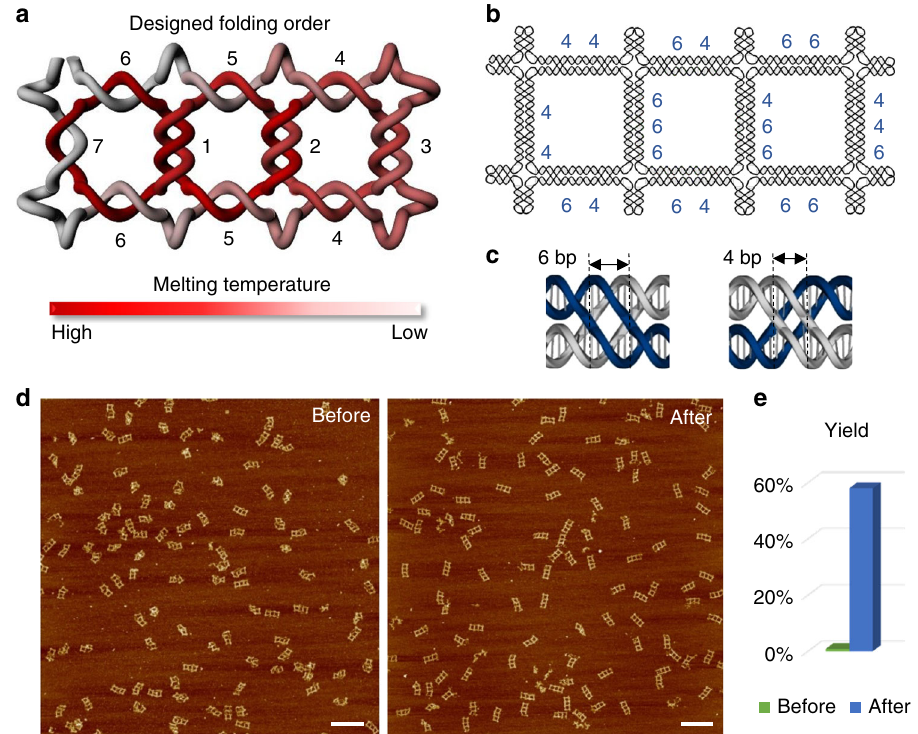
Fig. 3 Optimization of the folding pathway for ssDNA knots. a A designed model shows the selected best folding pathway (from one to seven) for the three-square structure with 23 crossings, by following our optimization rules. The red to gray color scale as well as the number one to seven represent the order of the paranemic cohesion interaction strengths on the edges from high to low (one to seven), based on the number and length of the paranemic cohesions involved as shown in b . c The paranemic interaction regions can be designed with lengths of 4 bp or 6 bp with distinct expected binding strengths (6 bp > 4 bp). Therefore, one is able to guide the folding order of the knot structure by controlling the sequences and lengths of the paranemic interactions in each individual edge. We compared the folding ef fi ciency of the known structures by using different folding pathways before and after optimization ( d ). The AFM images revealed a dramatic increase in the folding yield of well-form structures from 0.9% ( N = 221) to 57.9% ( N = 214) ( e ). The scale bars are 200